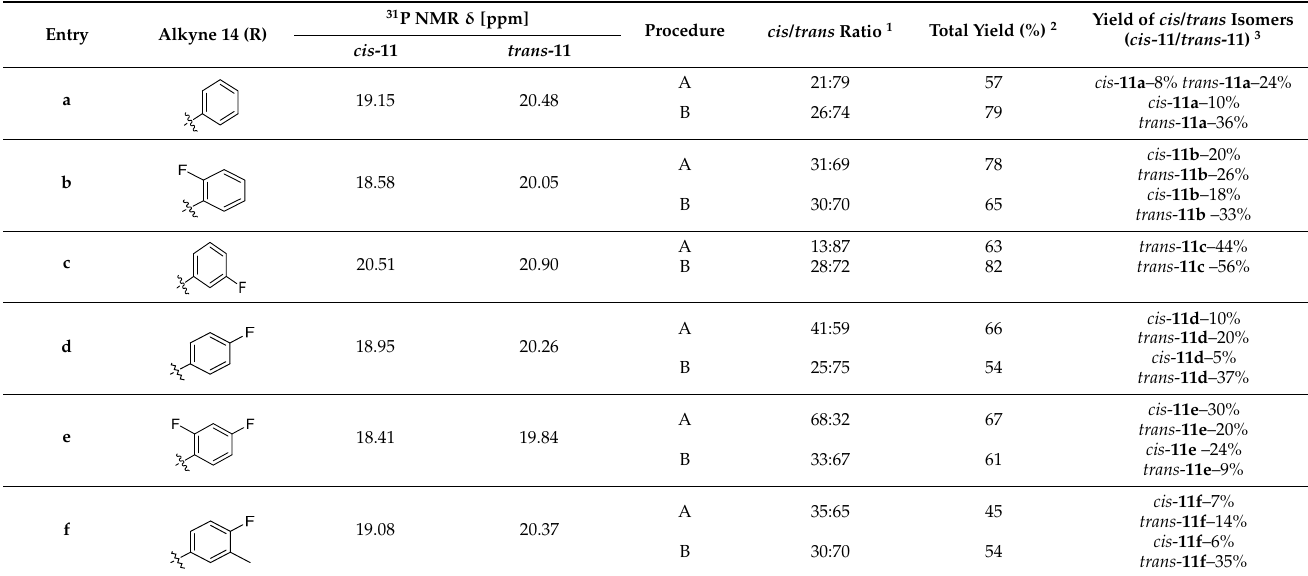
isomers and mixtures of isomers after column chromatography. 3 Yield of pure isomers obtained after chromatographic purification. Table 2. Cycloaddtion of nitrone 13 with arylalkynes 14 .